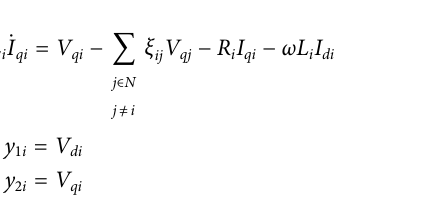
FIGURE 1 | The structure of interconnected microgrids with ring